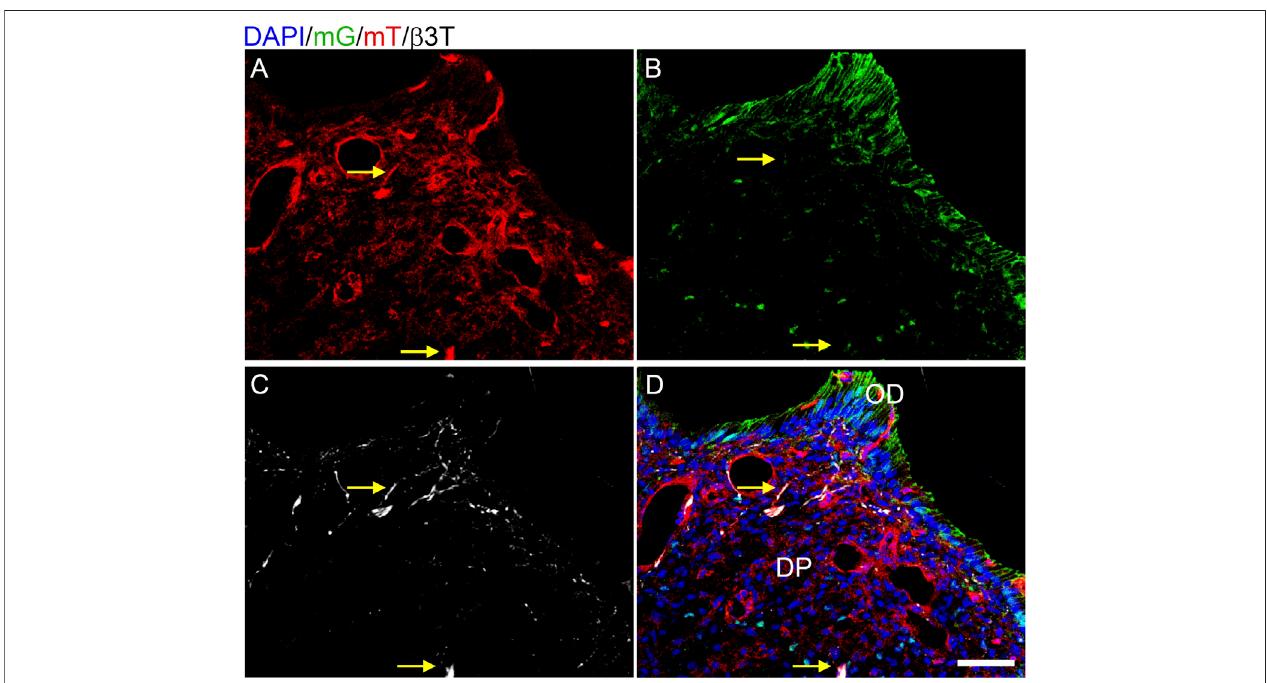
FIGURE1| Creactivity isisolated tothe mesenchyme inP7Osterix-Cre;ROSA26mTmGmouse dentalpulp.Z-stacks(10 μ mthick) werecollectedand presented in maximum projection mode to examine the Cre expression in DP structures. (A) membranous tomato red (mT) indicating an absence of Cre activity; (B) membranous green (mG) and nuclear Osterix-GFP indicating Cre activity; (C) β 3T immuno fl uorescence labelling axonal afferents in white. The β 3T correlated with only mT (A – D) and never mG (B – D) , demonstrating that Cre activity is isolated to the DP mesenchyme and odontoblasts (OD). Arrows highlight two particular regions of β 3T and mT without mG, with a dense β 3T+ structure indicated in the bottom center and a single- fi ber β 3T+ structure in the top center (C) . N = 8 Osterix-Cre;ROSA26mTmG mice. The scale bar is 50 μ m.